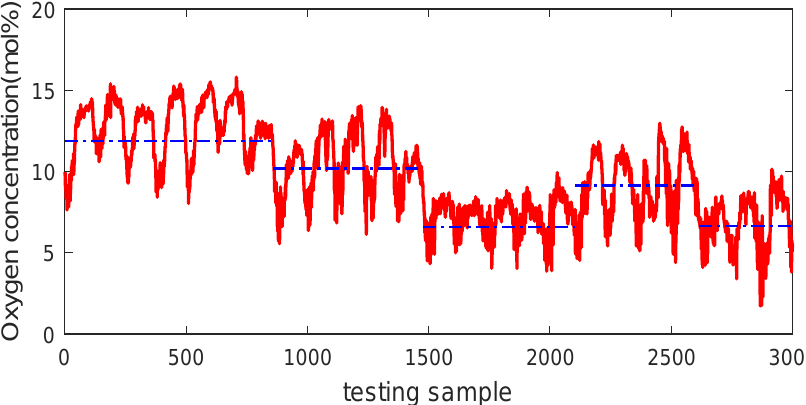
Figure 9. Visualization of multimode characteristics of the primary reformer.